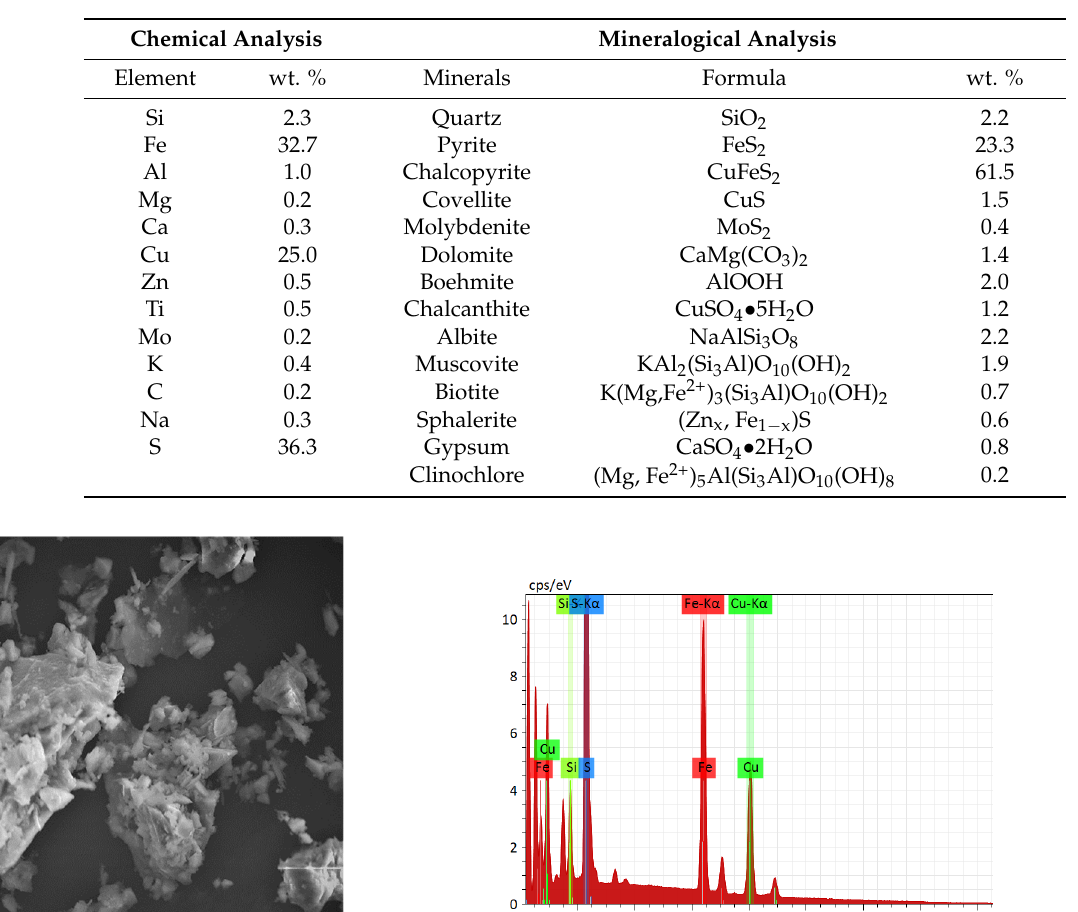
Table 1. Chemical and mineralogical analysis of the chalcopyrite concentrate.